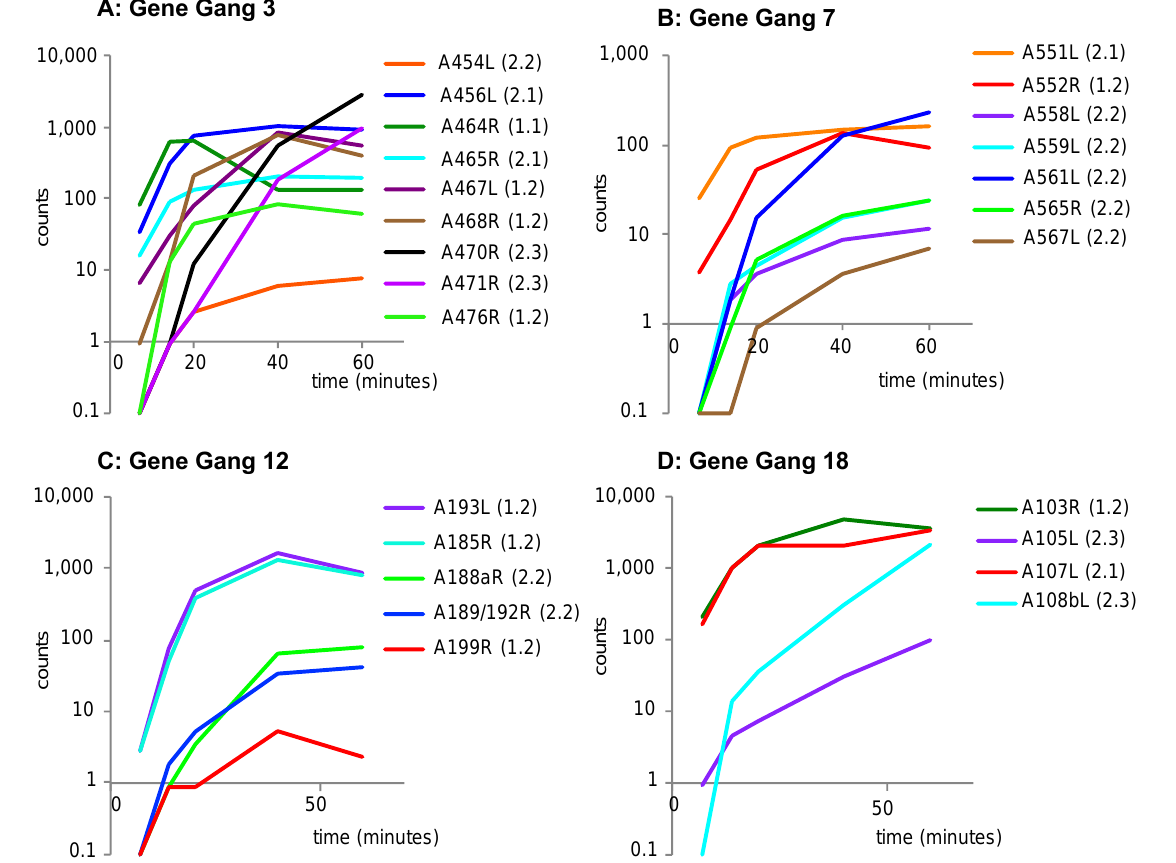
Figure 5. Transcriptional activation patterns of PBCV-1 genes from selected gangs. Each panel ( A – D ) reports the expression of genes in a single gene gang. Normalized sequence reads for multiple time points post infection (pi) were extracted from Blanc et al. (2014) [13] (see Table S1). The transcriptional activation patterns are noted next to the gene tag in parenthesis. The four selected gene gangs are the same as those used in Figure 4, and the color-coding of the annotated gene matches that in Figure 4. A value of 0.1 was given to normalize sequence read values of zero to allow for log 10 plotting.